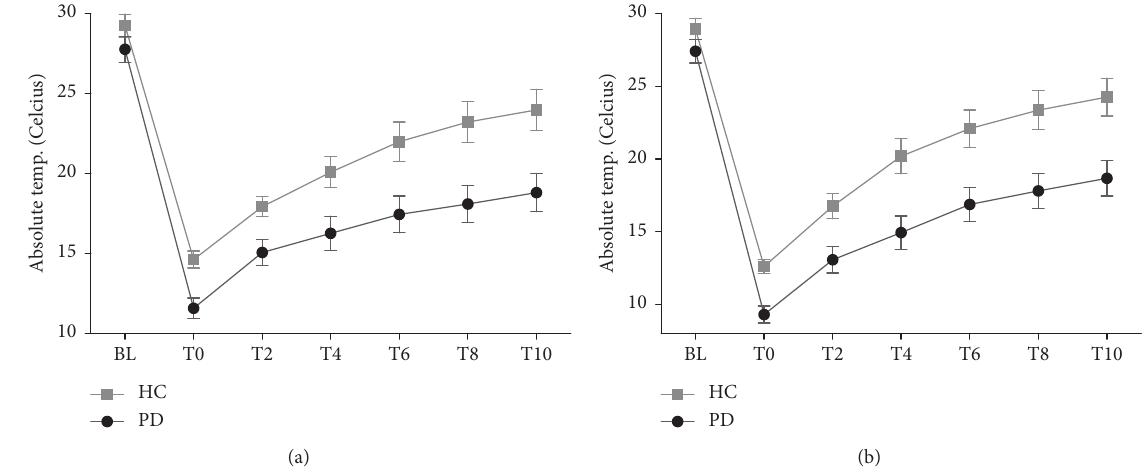
Figure 3: Cold stress test. Thermal recovery on the phalanx of the 3 rd finger (a) and the phalanx of the 5 th finger (b). Absolute temperature ±